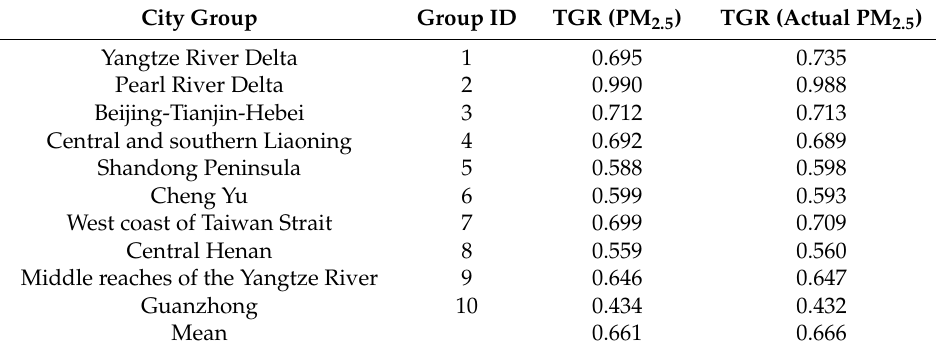
Table 6. Technology gap ratio under PM 2.5 .